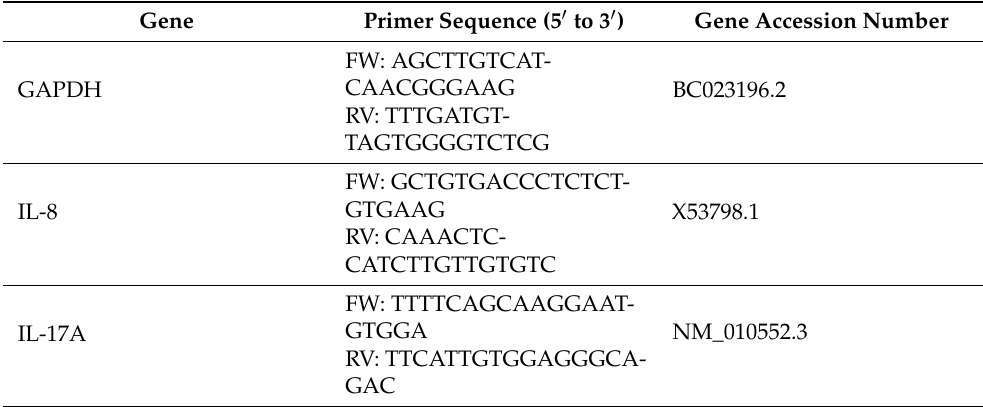
Table 2. Primer sequences used for the RT-qPCR assay.